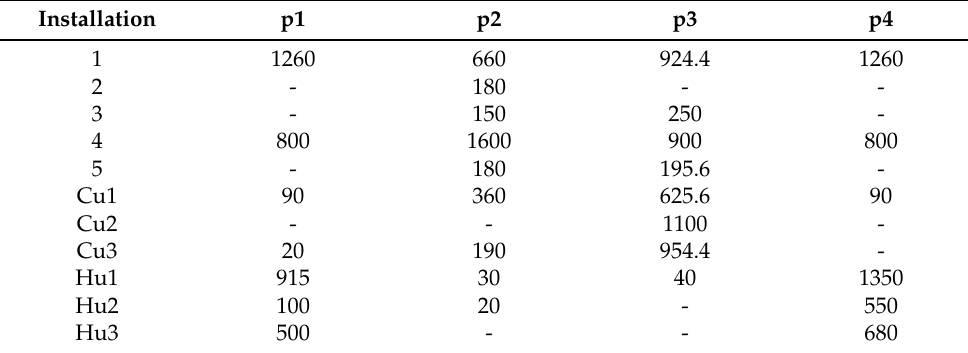
Table 7. Heat Flows without HP and ST case 2 (kW).